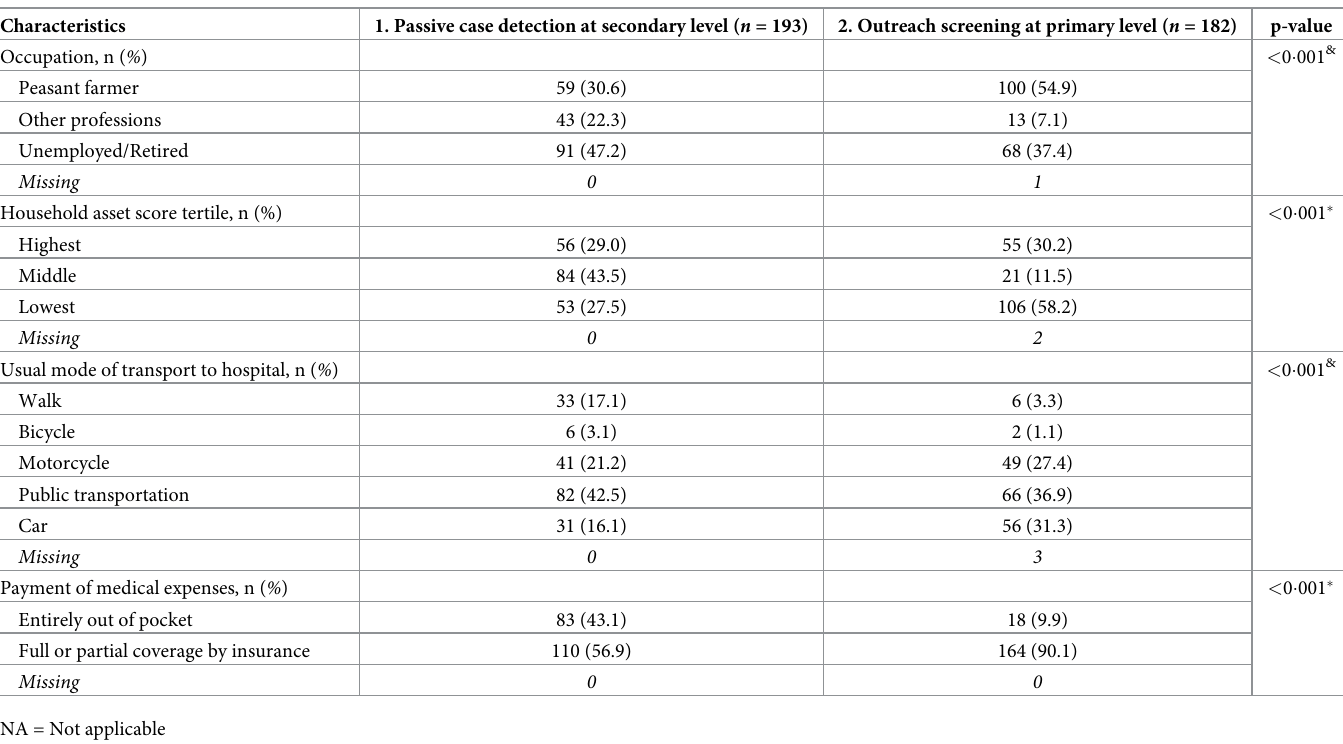
Table 1. Comparison of additional socioeconomic characteristics of participants in in the passive case detection and outreaching screening cohorts.